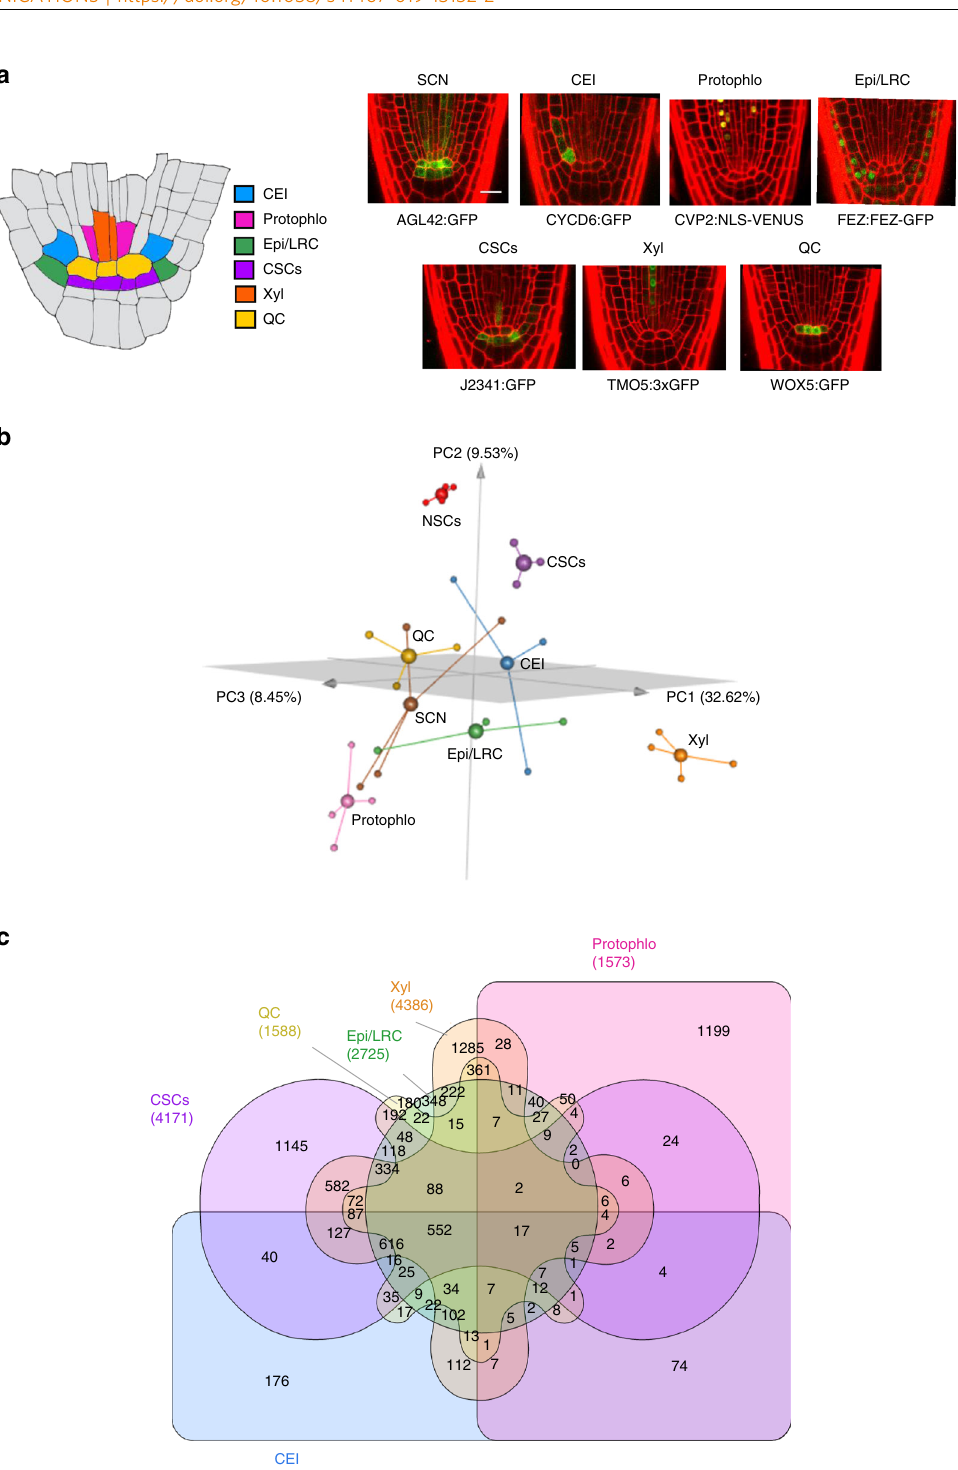
Fig. 1 Distribution of genes within the Arabidopsis root stem cell niche. a (left) Schematic of the Arabidopsis root stem cell niche. CEI cortex endodermis initials (blue), Protophlo protophloem (pink), Epi/LRC epidermis/lateral root cap initials (green), CSCs columella stem cells (purple), Xyl xylem initials (orange), QC quiescent center (yellow). (left) GFP marker lines used to transcriptionally pro fi le stem cells. SCN stem cell niche; Scale bar = 20 µ m. b 3D principal component analysis (PCA) of the stem cell transcriptional pro fi les. The x , y , and z axis represent the three largest sources of variation (i.e., three largest principal components) of the dataset. Small spheres are biological replicates, large spheres are centroids. Red — Non-stem cells (NSCs); Brown — SCN; Blue — CEI; Pink — Protophlo; Green — Epi/LRC; Purple — CSCs; Orange — Xyl; Yellow — QC; c Distribution of the 9266 stem cell-enriched genes across the stem cell niche. Enrichment criteria are q -value < 0.05 (from PoissonSeq) and fold-change in expression